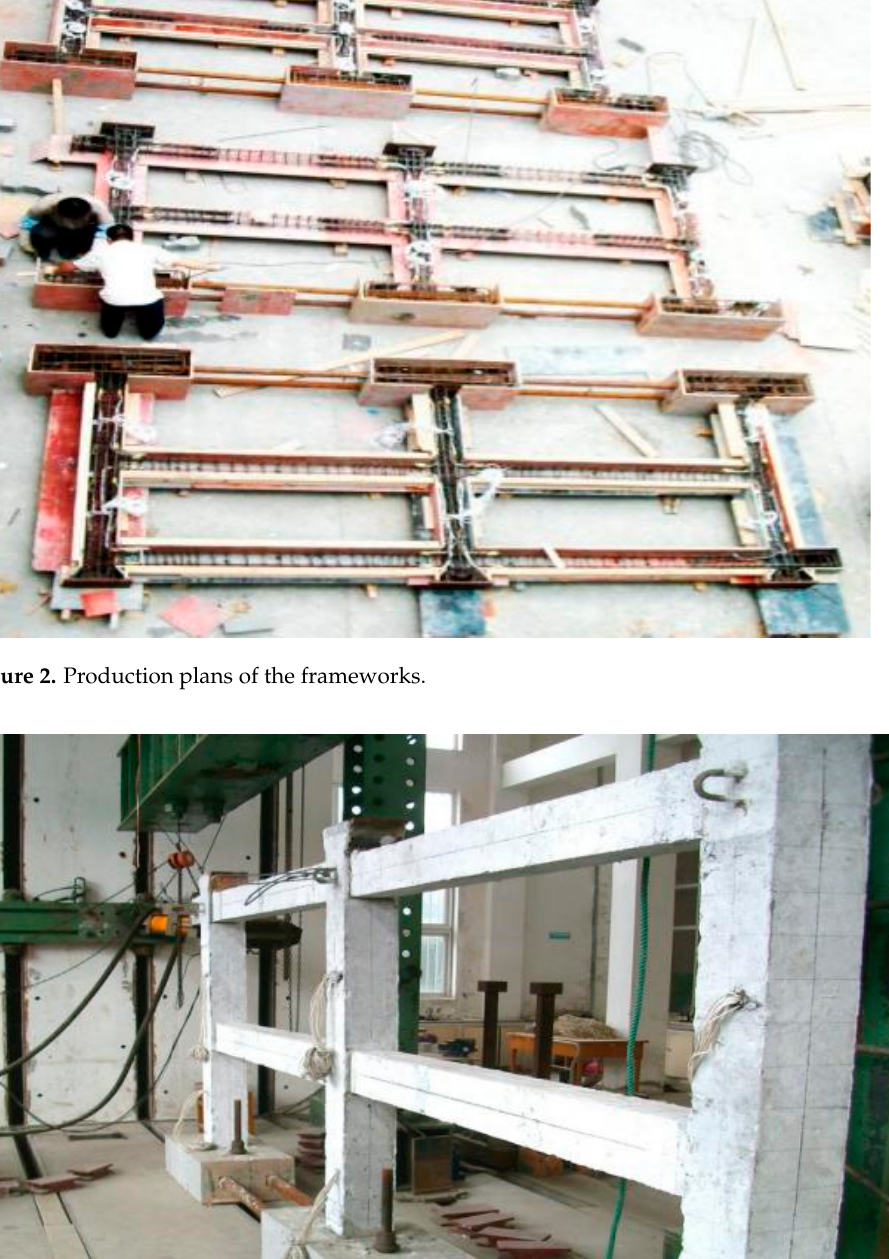
Figure 3. Accomplished test frame.